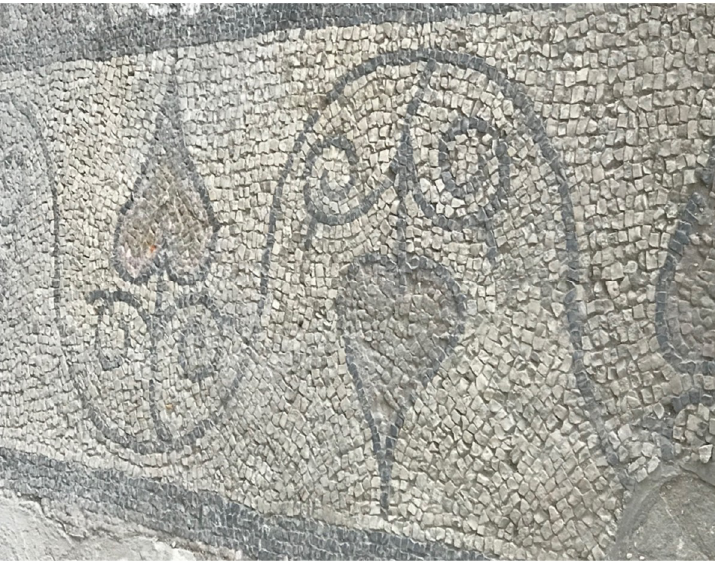
Figure 1. Photo of Roman Mosaic from Constanta (Romania)—the presented surface is 2 × 3.5 m 2 .